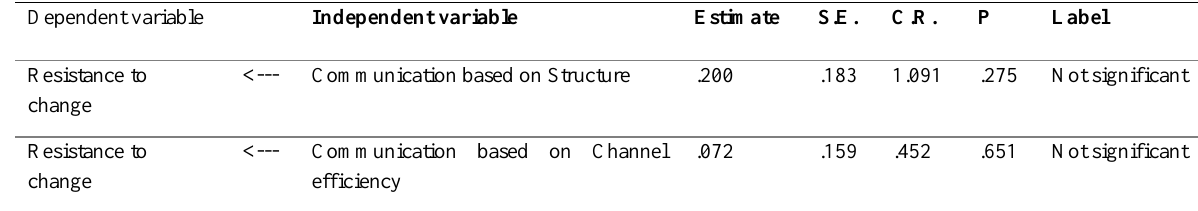
Table 4: Path regression estimate of the proposed